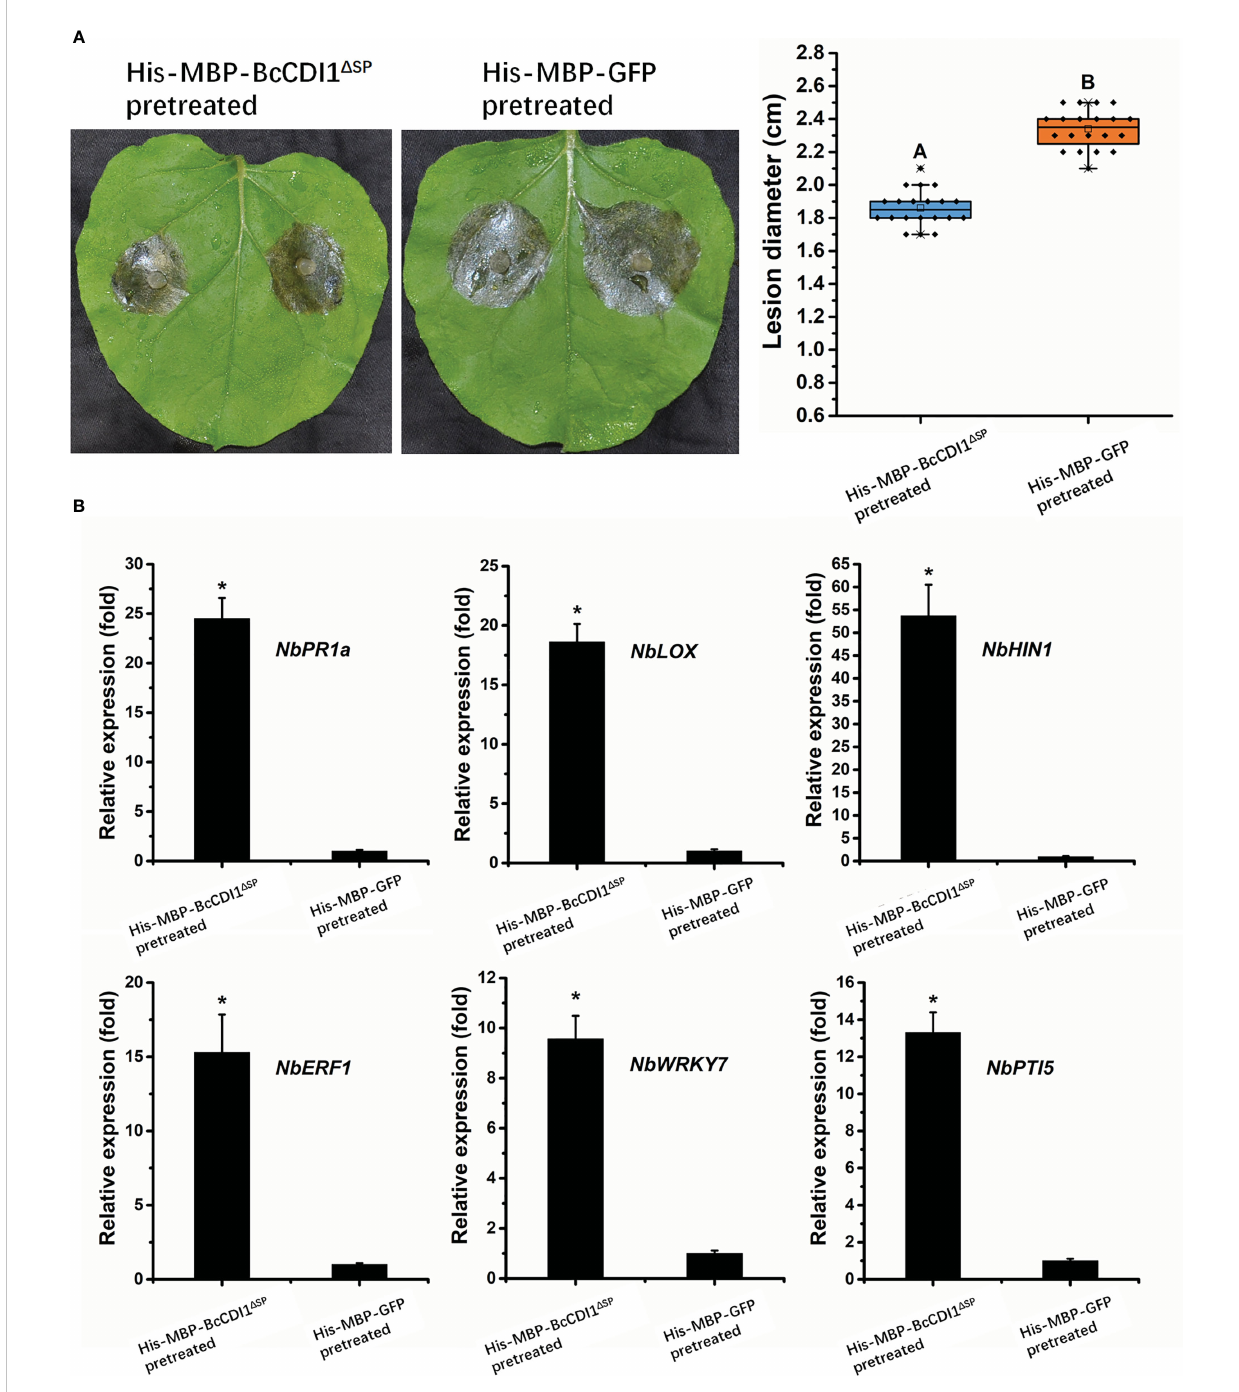
FIGURE 6 BcCDI1 induces resistance in tobacco. (A) Nicotiana benthamiana leaves were in fi ltrated with 5 m g/ml of puri fi ed BcCDI1 or GFP protein. After 2 days, the in fi ltrated leaves were inoculated with Botrytis cinerea in a humid chamber. The lesions were photographed and measured at 48 hpi. Data were obtained from three independent experiments with a total of 20 samples. In box plots, whiskers indicate the minimum and maximum values; the line indicates the median; the box boundaries indicate the upper (25th percentile) and lower (75th percentile) quartiles. All data are plotted as black dots. Different letters in the graph indicate statistical differences at P ≤ 0.01 using ANOVA (one-way) followed by Tukey ’ s post-hoc test. (B) The relative expression levels of defense-related genes from tobacco leaves treated with BcCDI1 or GFP for 48 h were determined by RT-qPCR analysis. The expression level of the indicated genes in GFP-treated leaves was set as 1. The expression level of the tobacco NbEF1 a gene was used to normalize different samples. Data represent means and standard deviations of three independent replicates. Asterisks in the graph indicate statistical differences at P ≤ 0.01 using ANOVA (one-way) followed by Tukey ’ s post-hoc